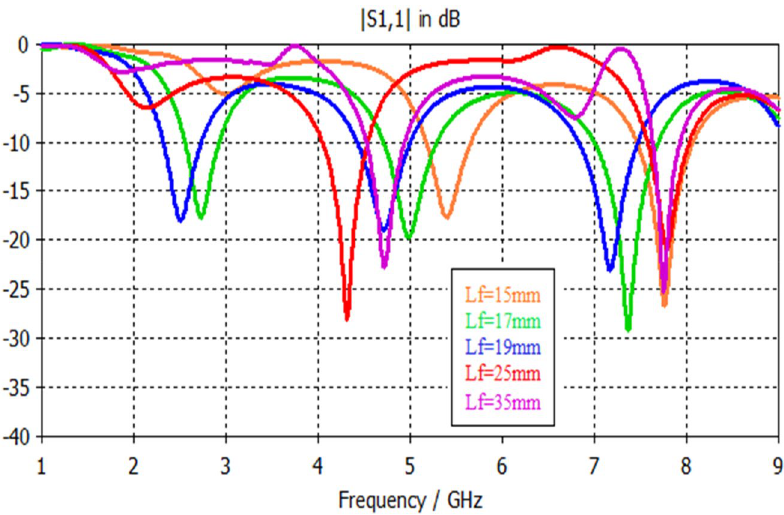
Figure 20. S11 responses of Antenna4 topology using a feedline length as a